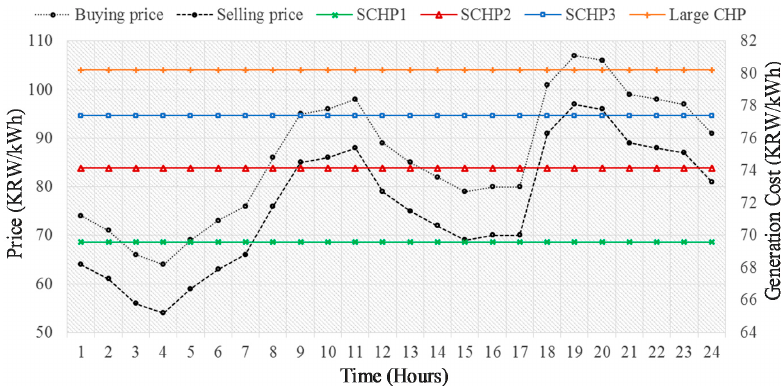
Figure 5. Time-of-use market price signals with generation costs of CHPs.